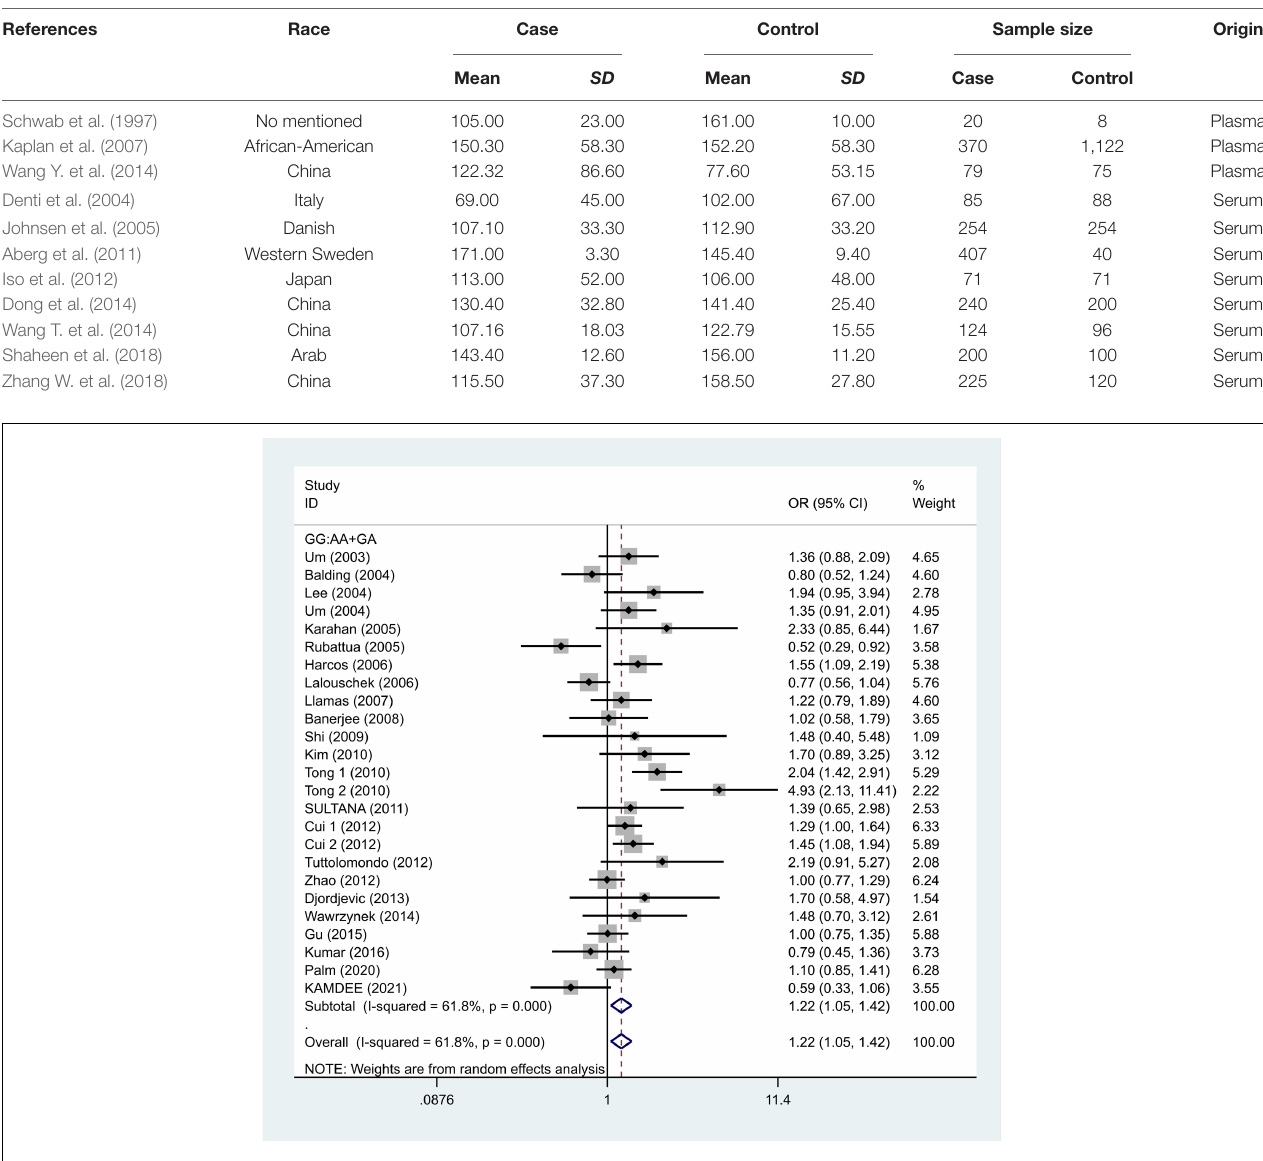
TABLE 3 | Summary of studies exploring the relationship between the levels of IGF-1 and IS.